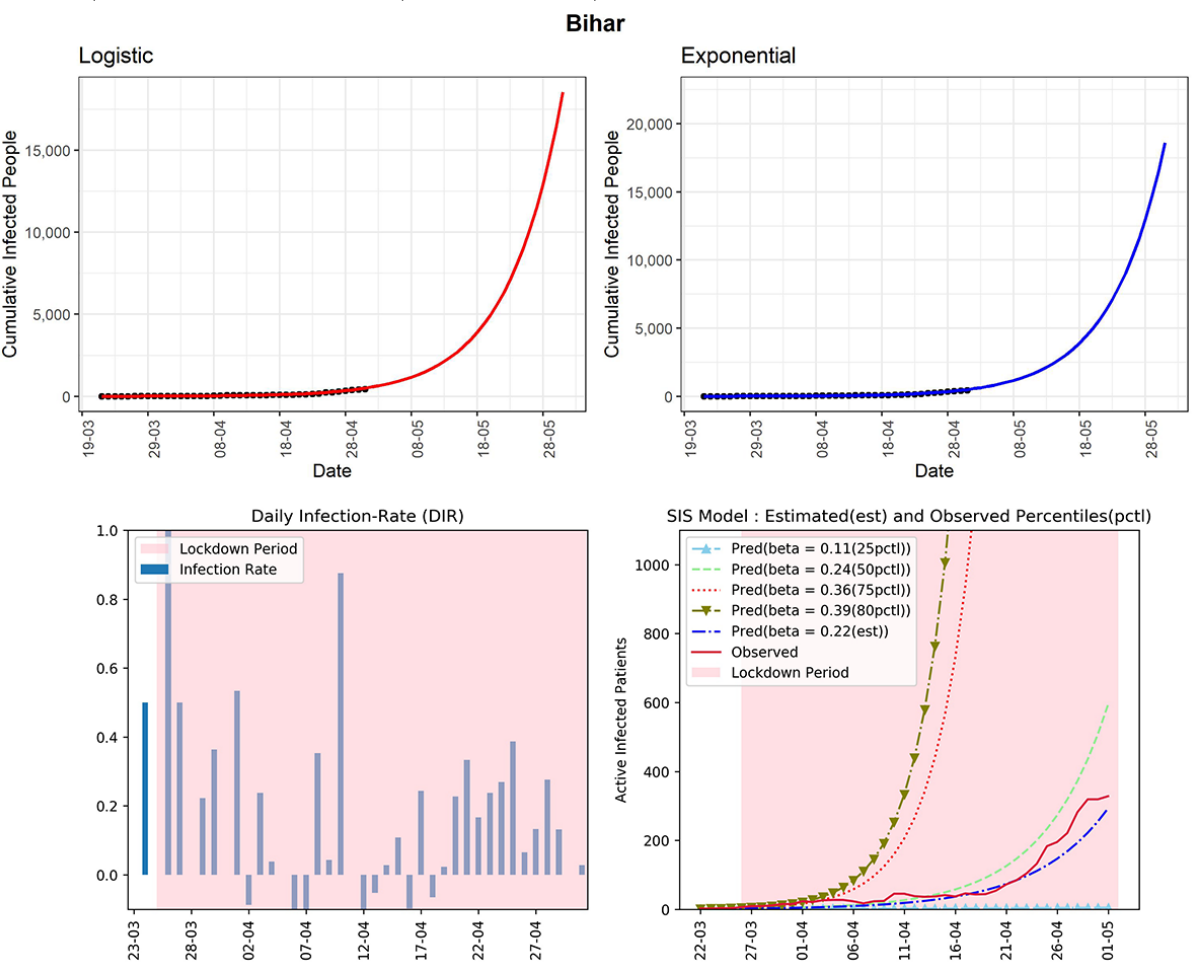
Figure 19. Graphs for the state of Bihar. SIS: